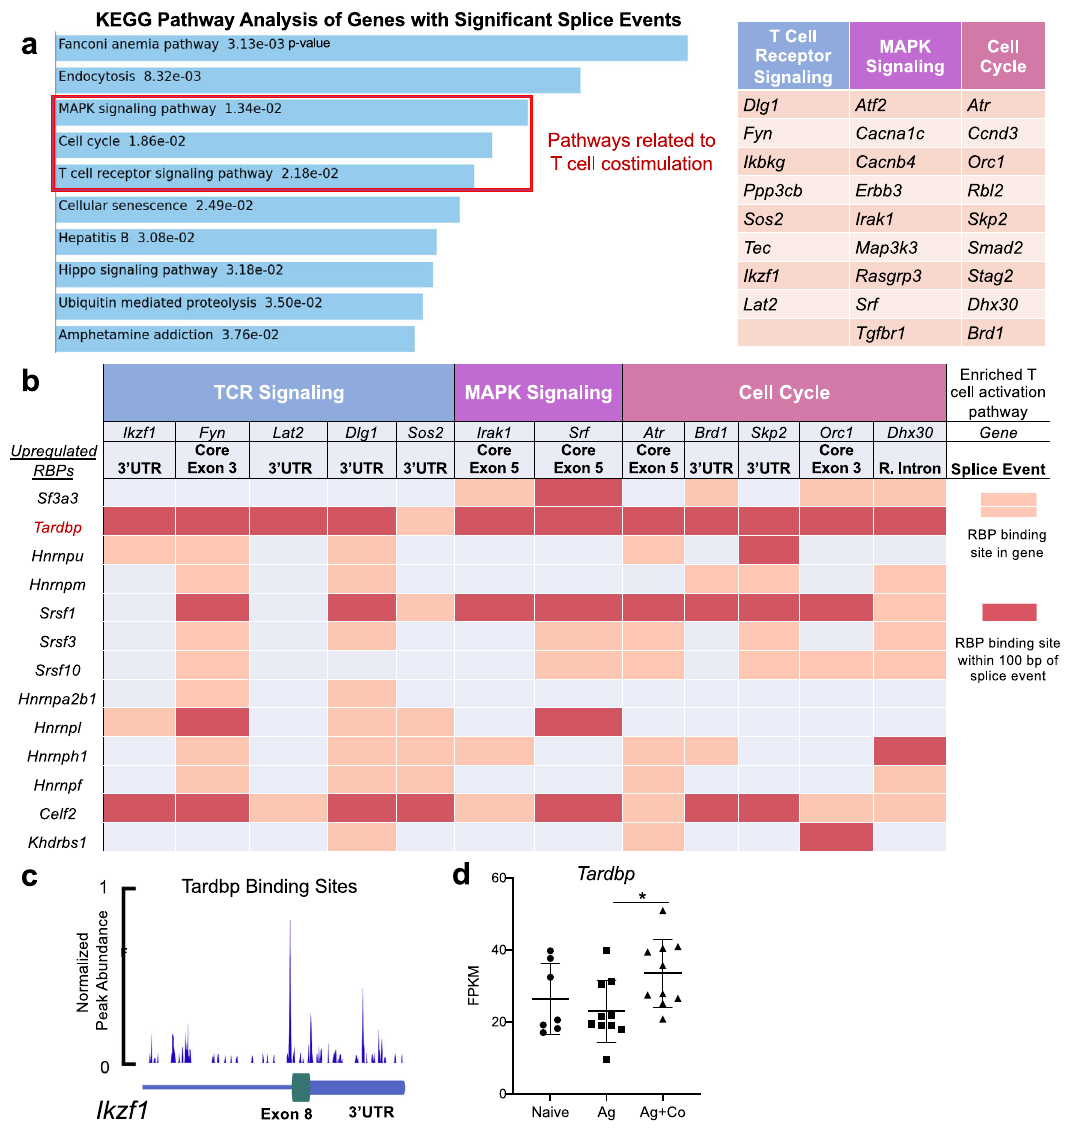
Fig. 3 RBP Tardbp binds to immune-regulatory genes containing splicing events induced by costimulation of CD8 + T cells. a KEGG pathway analysis of 950 genes containing 1464 RNA splice events from Ag + Costim vs Ag groups in Fig. 2a ranked by p value as well as 26 genes with splice events grouped by 3 immune-related pathways. b Binding of 13 signi fi cantly upregulated RBPs from 1g to a representative subset of 12 immune-related splice events found in ( a ). c CLIP-seq data from ENCODE database for Tardbp binding to RNA in Ikzf1 . d Relative FPKM of Tardbp from two independent RNA-seq datasets comparing naïve, Ag, and Ag + Co CD8 + T cells from dataset in Fig. 1 and Supplementary Fig. 2, n = 7 for naïve, n = 10 for Ag and Ag + Co. Data are presented as mean values + / − SD using a two-sided t test with Benjamini, Krieger and Yekutieli to control FDR where * represents n digits after decimal for p value. Source data are provided as a Source Data fi showed a signi fi cant decrease in expression of Isoform II in the Tardbp KO group when compared with control gRNA, validating that Tardbp also controlled protein isoform splicing changes in human cells (Fig. 4f). Both mouse and human Ikzf1 isoform ratio changes were quanti fi ed among three independent experiments shown in 4e and f bottom panels. These results indicated that Tardbp mediates speci fi c exon changes in TCR signaling genes in activated CD8 + T cells.